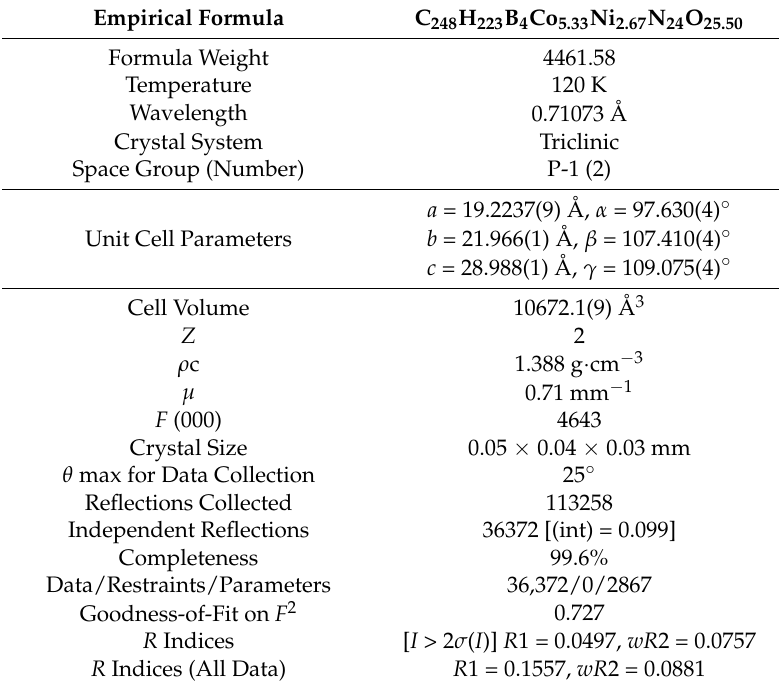
Table 1. Crystal data and structure refinement details for ( 1